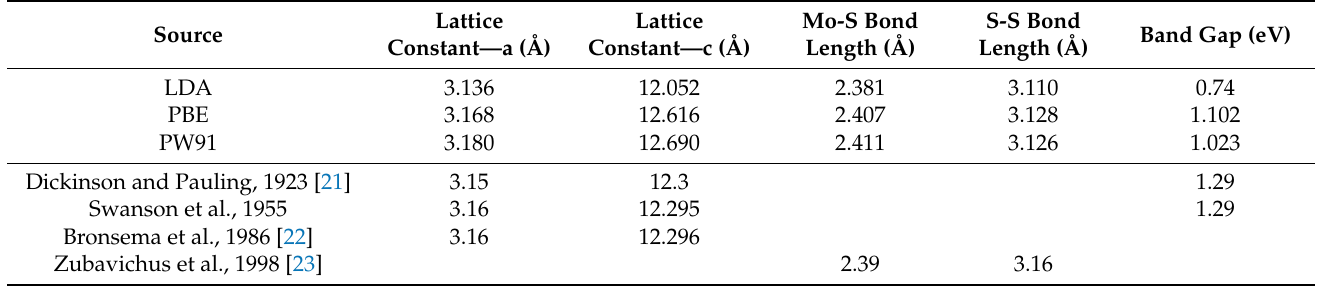
Figure 1. Supercell of MoS 2 (2H) crystal (5 × 5 × 2) ( a ): three-dimensional, ( b ): top view (001), ( c ): side view (110) (yellow ball is sulfur atom and blue ball is molybdenum atom). Table 1. Comparison of DFT calculation using different functional and experimental parameters in MoS2 cell geometry